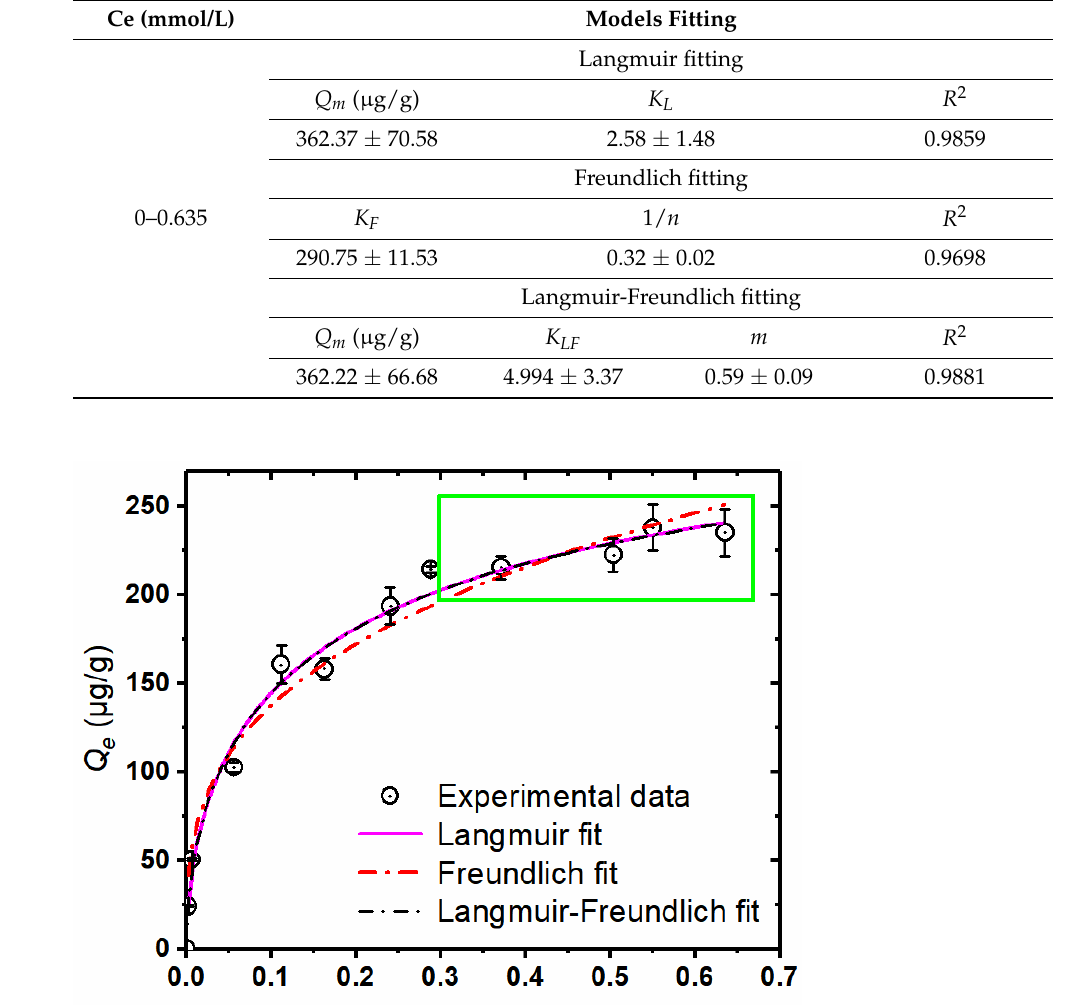
Table 3. Isotherm parameters for adsorption of MTAs V on the sediment.